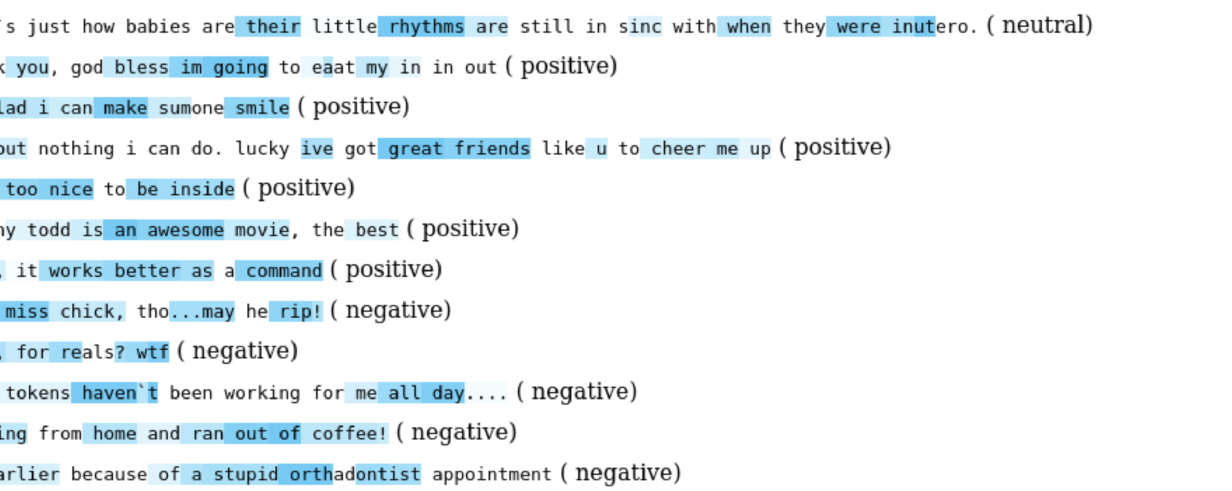
Figure 16. Examples of multilabel attention. Each row is an input sentence with highlighted predicted activation. The darker blue represents the higher probability. It is important to note that our framework is capable of predicting multiple labels from one sentence, which can result in better machine–human interaction